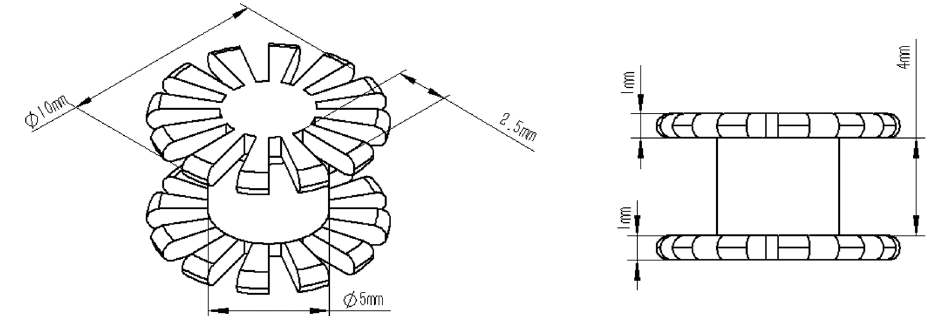
Figure 1: VSDO engineering